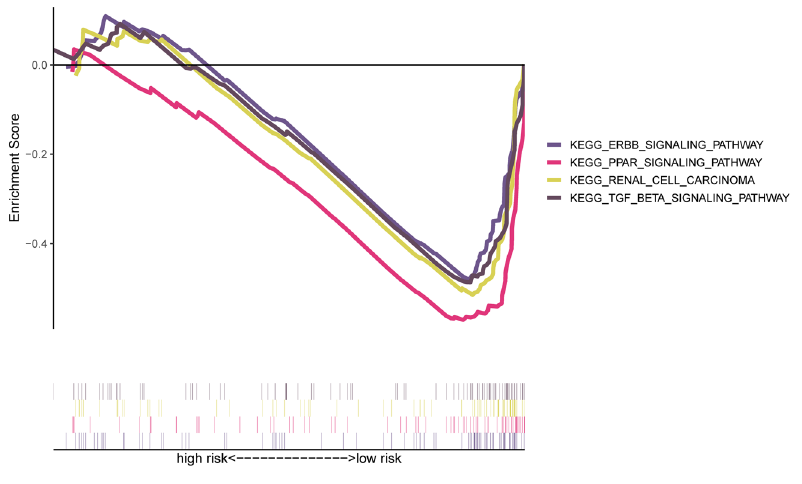
Figure 9. GSEA of